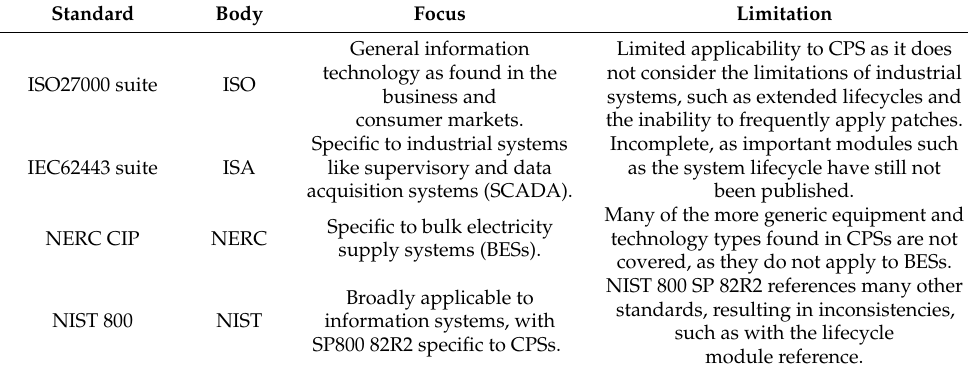
Table 1. Overview and comparison of standards and frameworks and their